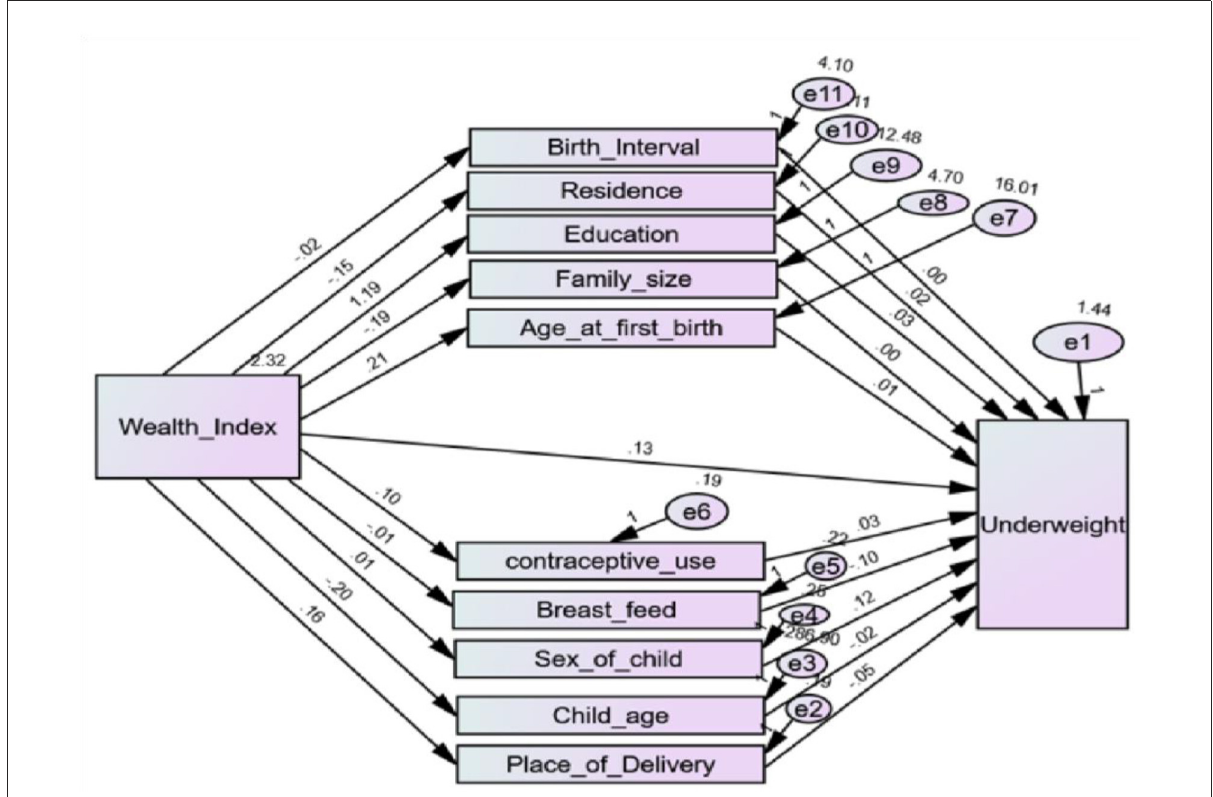
FIGURE4 Path diagram of mediators of the link between the wealth index and